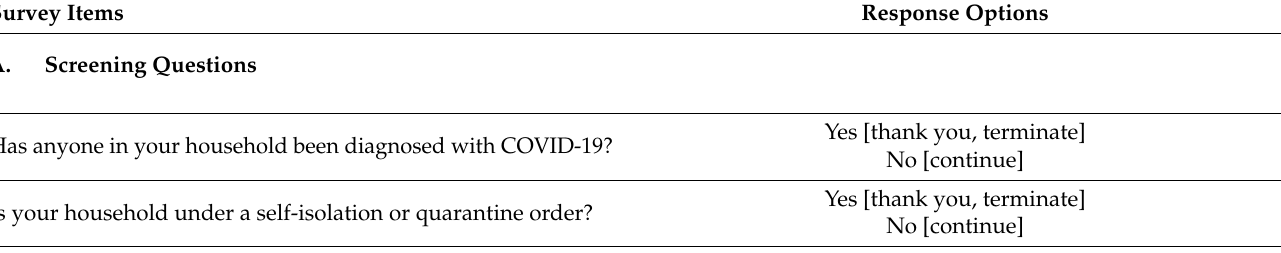
Table A1. Selected items from the parent-reported children and youth movement and play behaviours survey (adapted from Moore et al., 2020, and sent to participants from the National Physical Activity Measurement (NPAM) study to complete electronically using RedCap© in May